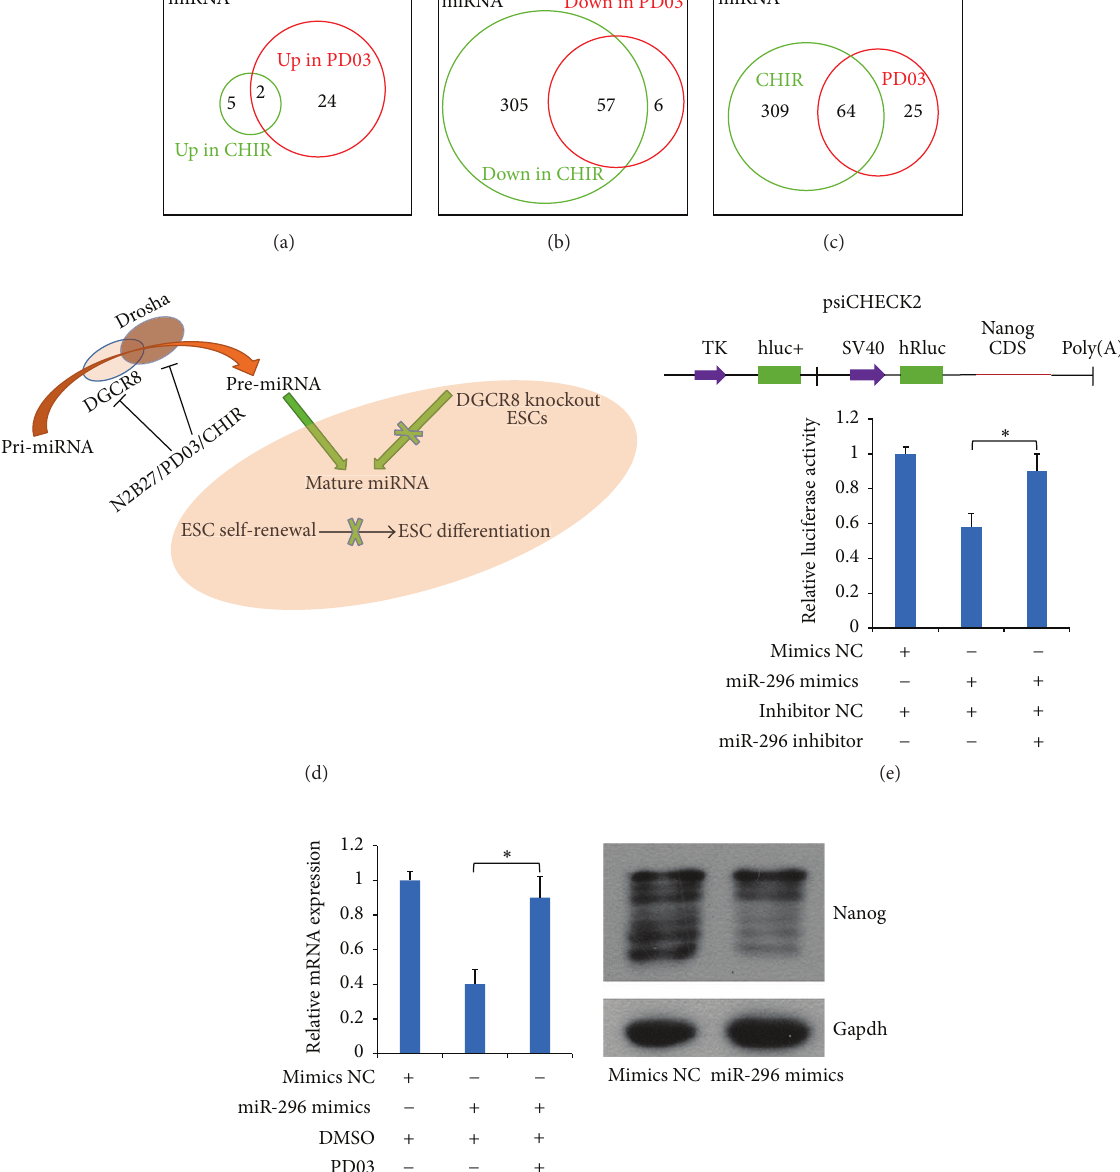
indicate mean ± SD of three independent experiments, ∗ 𝑝 < 0.05 compared with controls. (g) miR-296 regulates Nanog expression. ESCs were transfected with mimics NC or miR-296 mimics for 24 h; then the protein expression level of Nanog was analyzed by western blot. Gapdh was used as a normalization